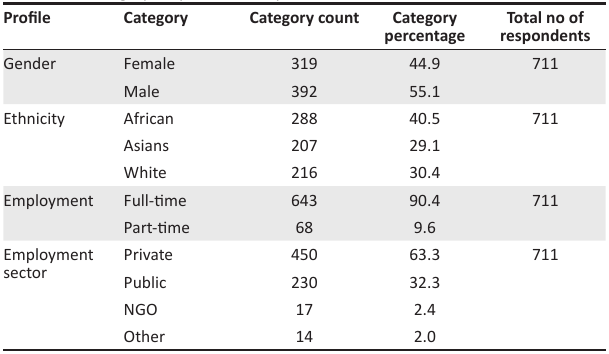
TABLE 1: Demographic profile of respondents.